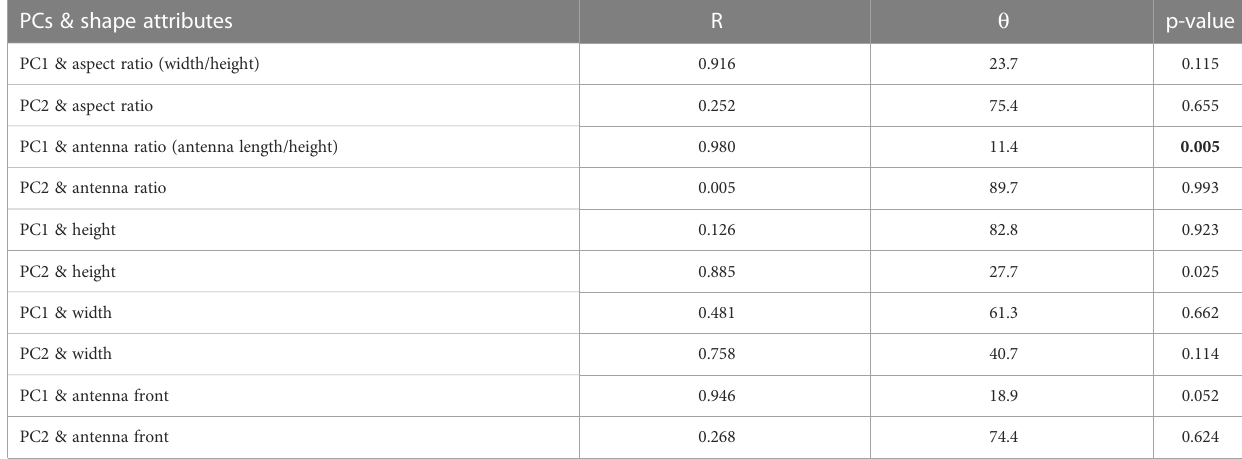
Bold values indicate statistical signi fi